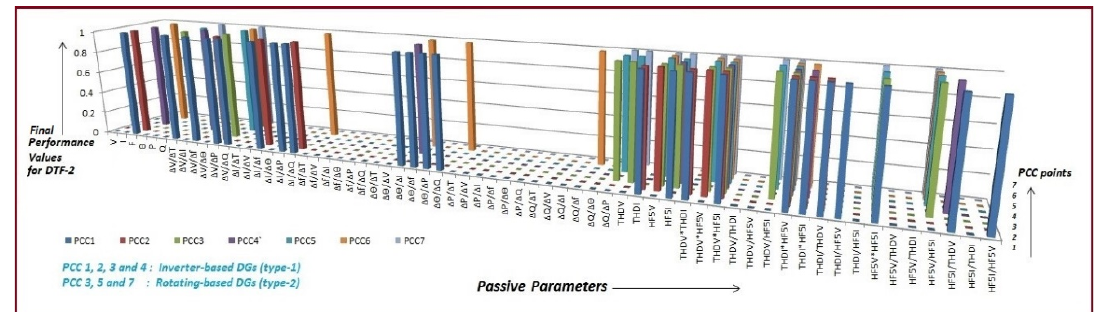
Figure 7. Effective passive parameters for DTF-2 (IEEE 34 bus system) for the LPM range of PCCs 1 to 7.